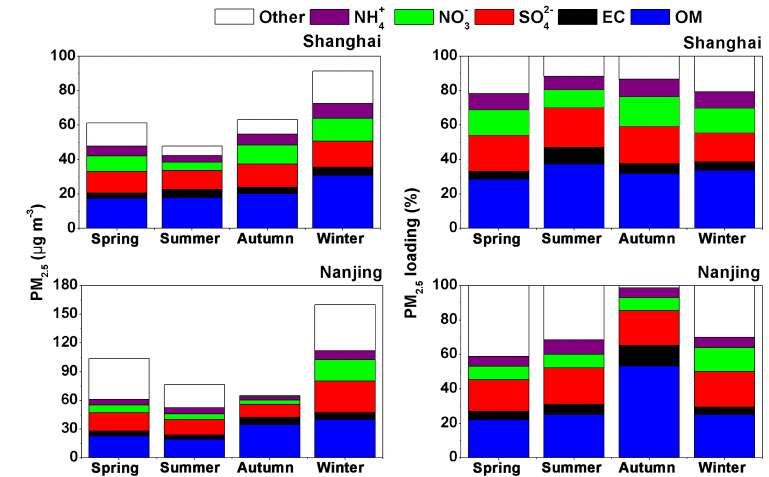
Figure 5. Seasonal PM 2 . 5 and dominant chemical components in